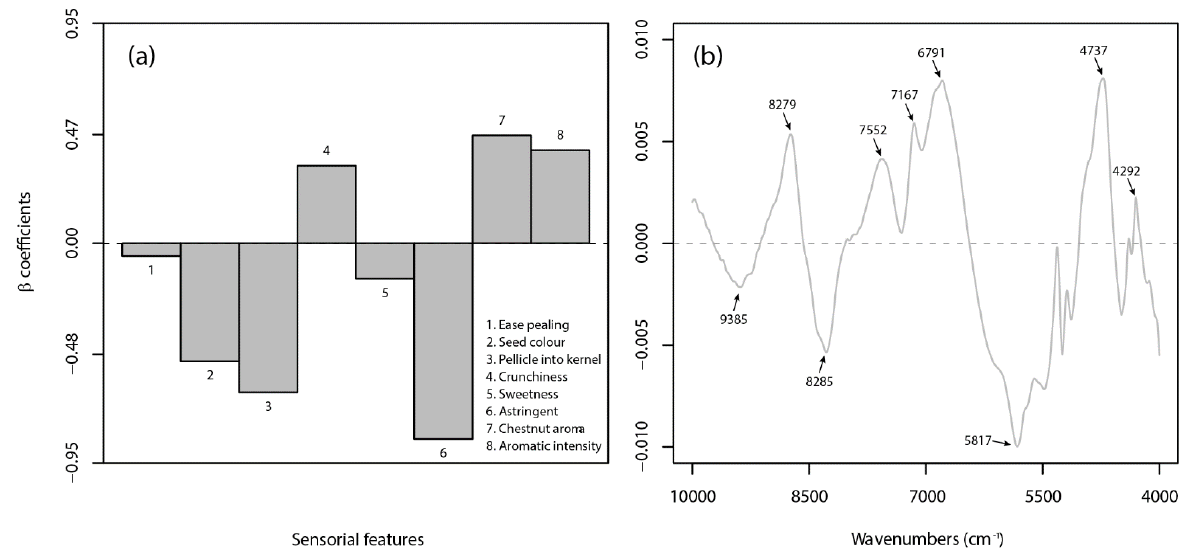
Figure 4. ß-coefficients plots for the best sensory-based ( a ) and spectral-based ( b ) PLS-DA models on raw chestnuts.